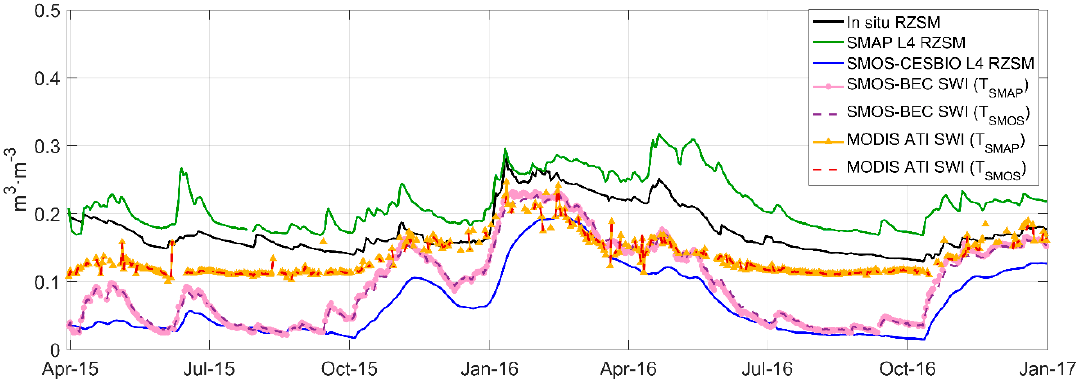
Figure 2. Average time series of the different RZSM estimates across REMEDHUS.